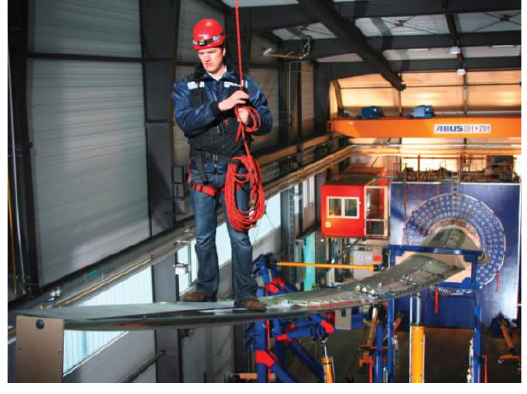
Figure 26: Inspection of a rotor blade